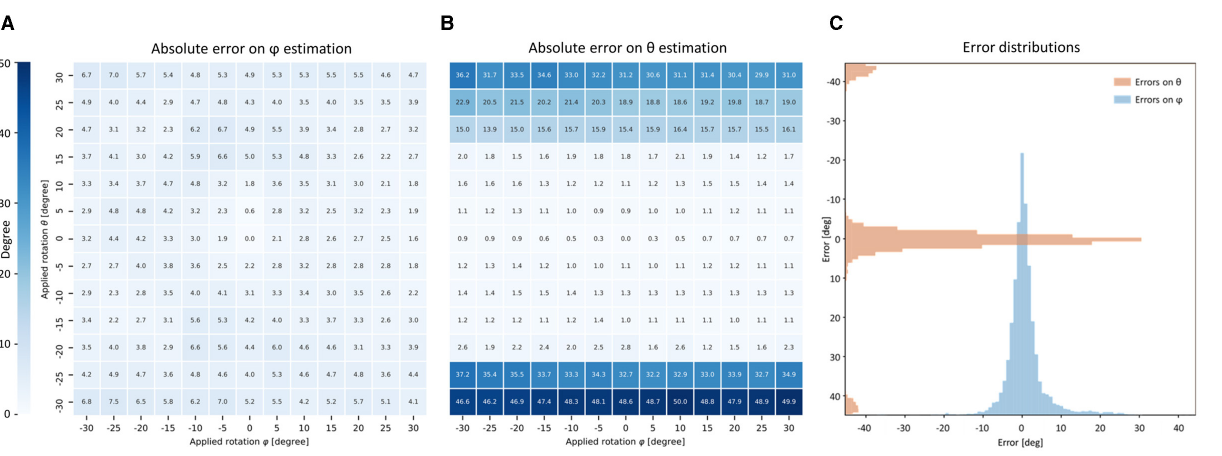
FIGURE 6 | Accuracy of FFT-based orientation analysis. (A,B) Tables show the performance of the FFT-based orientation analysis averaged on 140 portions of 16 16 16 µ m randomly extracted from three IVS strips. Virtual rotations on XY -plane ( azimuth ϕ ) and out-of-plane ( elevation θ ) are applied to each portion of Z-bands × signal. The absolute error of the proposed method is shown in degree for both ϕ and θ . (C) Relative errors are grouped for all the 13 the 140 portions and shown as